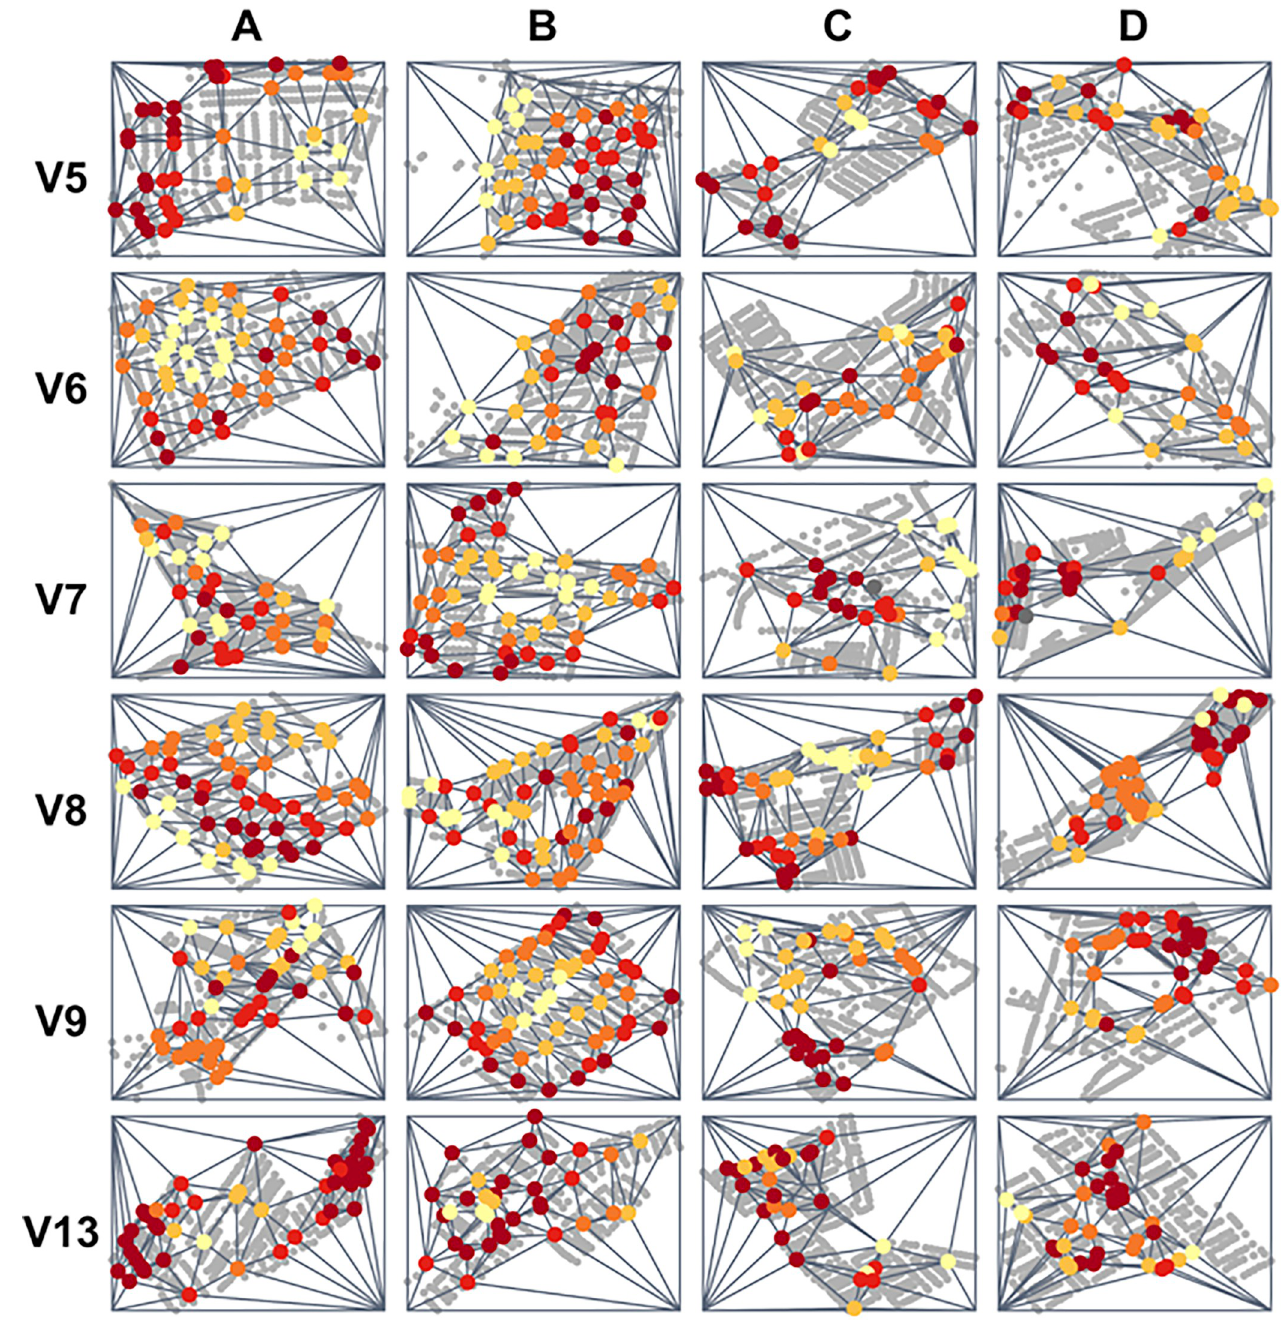
Fig 5. Spatial coverage maps for each participant in the Socabaya trial. Rows represent participants (represented by ‘V[number]’), columns represent trial arms. Incentives used in each arm were: (A) Fixed incentive for spatial coverage and a stochastic incentive for inspecting higher risk houses; (B) Fixed incentive for spatial coverage and an increased payout of the stochastic incentive for inspecting higher risk houses; (C) no incentives (control arm); and (D) pay per detection. Spatial coverage is represented by Delaunay triangulation in which triangles are formed connecting inspected houses (colored dots represent the inspected houses by the infestation risk shown as a gradient from yellow (lowest quintile) to dark red (highest quintile). Arms A and B both had significantly higher spatial coverage than Arms C and D (paired t-test, p < 0.01, p < 0.001, respectively).